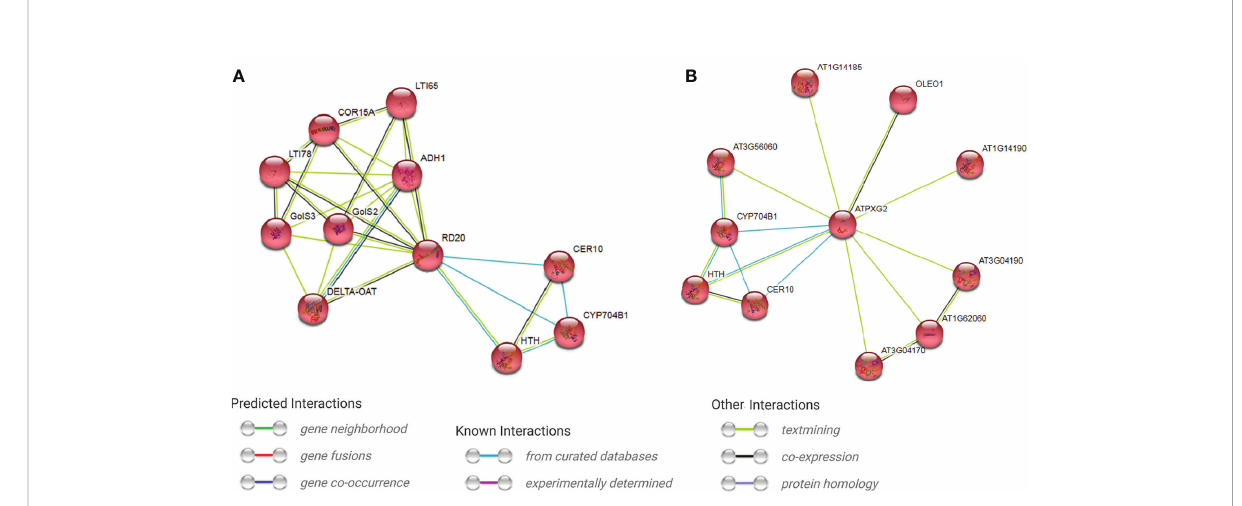
FIGURE 6 Protein networks for two key genes (containing trinucleotide SSR repeats) acting in cutin, suberine and wax biosynthesis pathway determined by MCL clustering in STRING database. (A) Caleosine (RD20) protein network, (B) Peroxygenease 2 (PXG2) protein network.